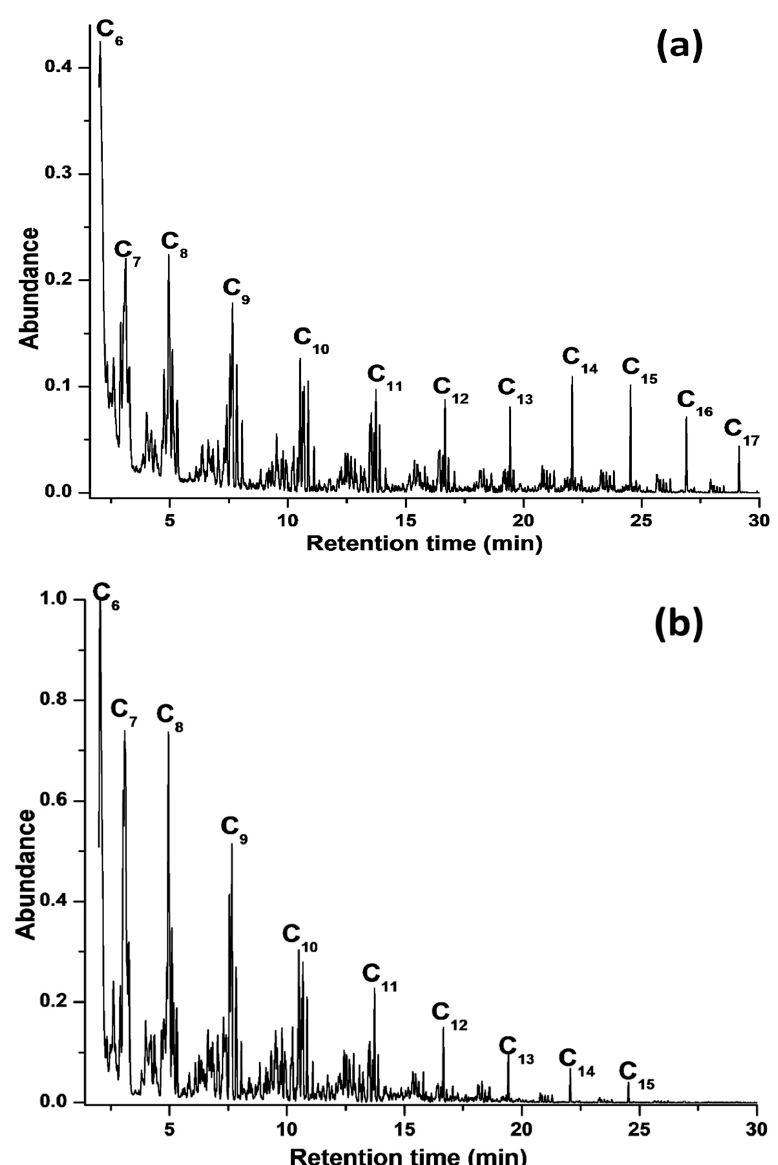
Figure 9. GC-MS chromatograms of FTS liquid products using the catalyst ( a ) Co/NS-Al-B and ( b ) Co/NS-Al-A. Table 2. Catalytic performance and major components of synthesized liquid FTS fuel over the